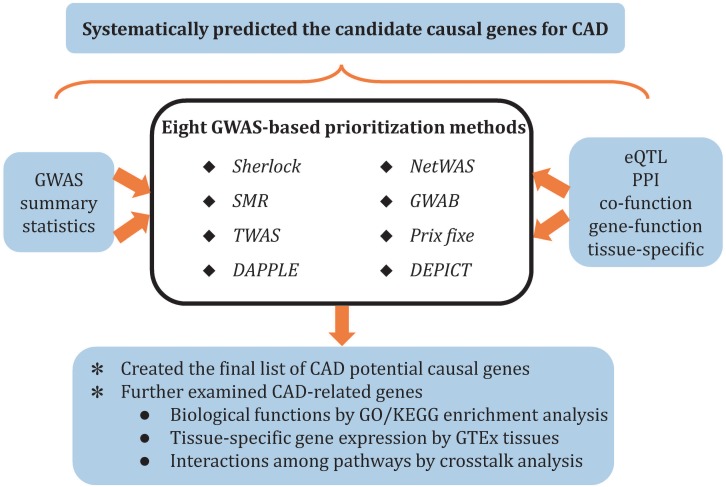
Overview of study pipelines.